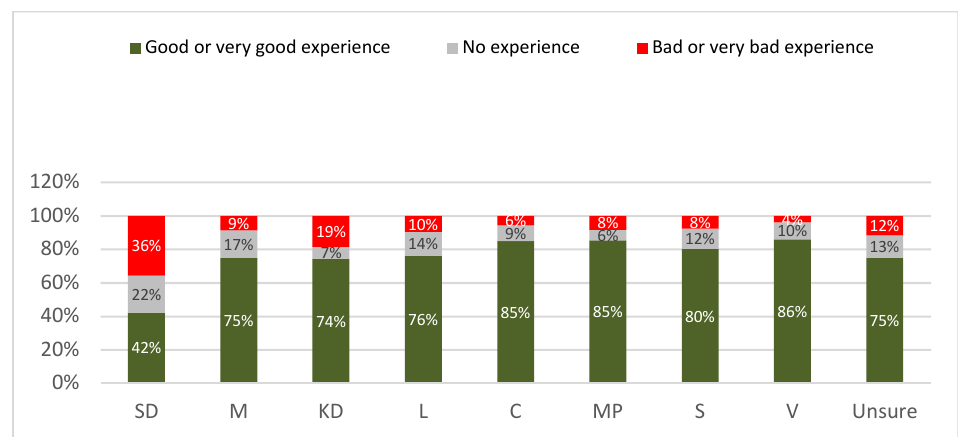
Figure 5. Experiences from working/studying with people with foreign background ( n = 1035).